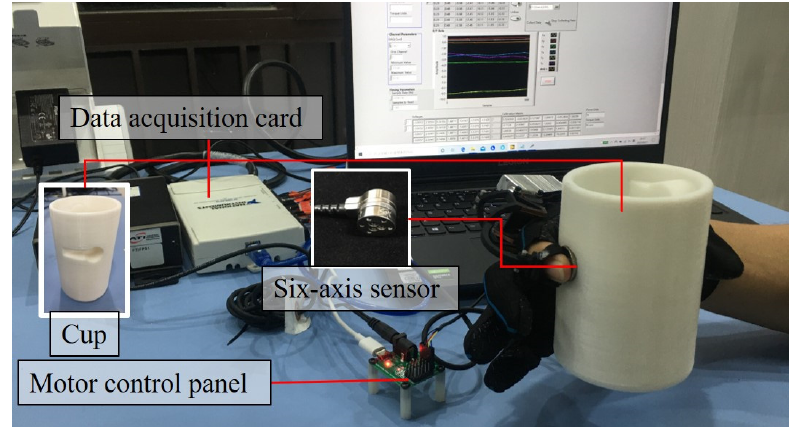
Figure 17. Experiment for grasping simulation.